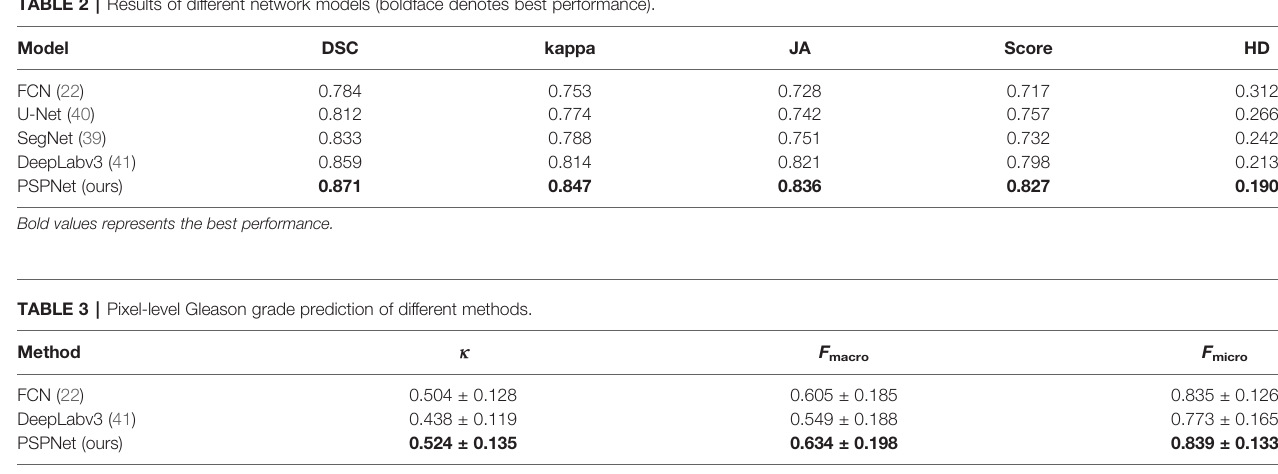
Bold values represents the best